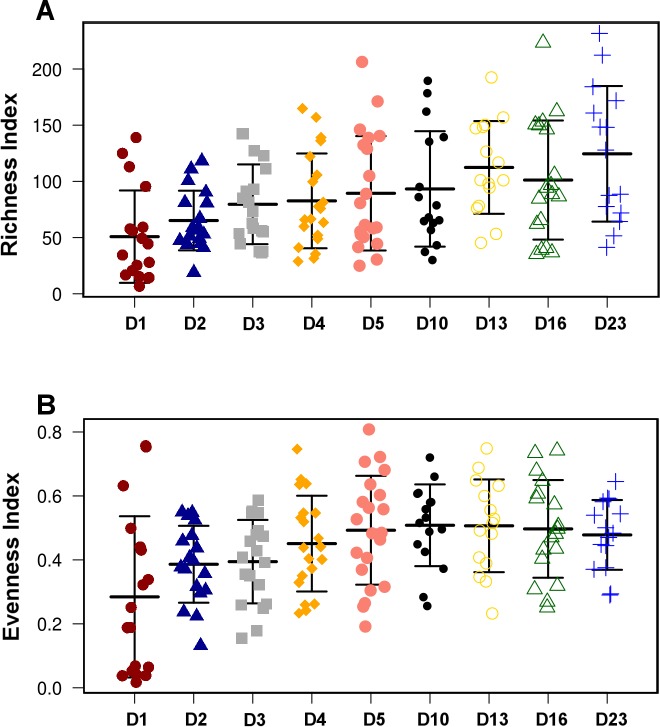
Overall diversity changes during the first 23 days of broiler microbiota development.Both Richness (A) and Evenness index (B) were significantly (ANOVA) different between the timepoints (P = 1.58E−4 and P = 2.02E−4, respectively). The present figure is composed of all three treatment groups, however, this trend of increasing richness and evenness reproducible in all individual treatment groups shown in Fig. S2.